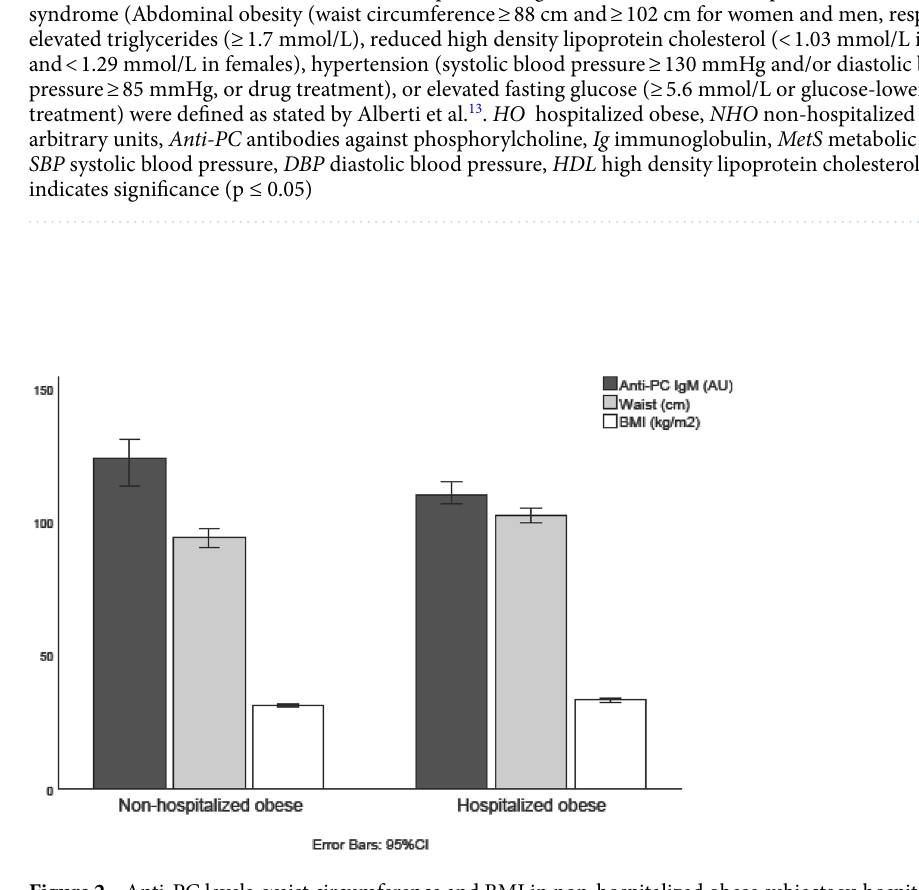
Figure 2. Anti-PC levels, waist circumference and BMI in non-hospitalized obese subjects vs hospitalized obese subjects. Values are median (anti-PC IgM) or mean (waist circumference and BMI). Error bars represent the 95% confidence